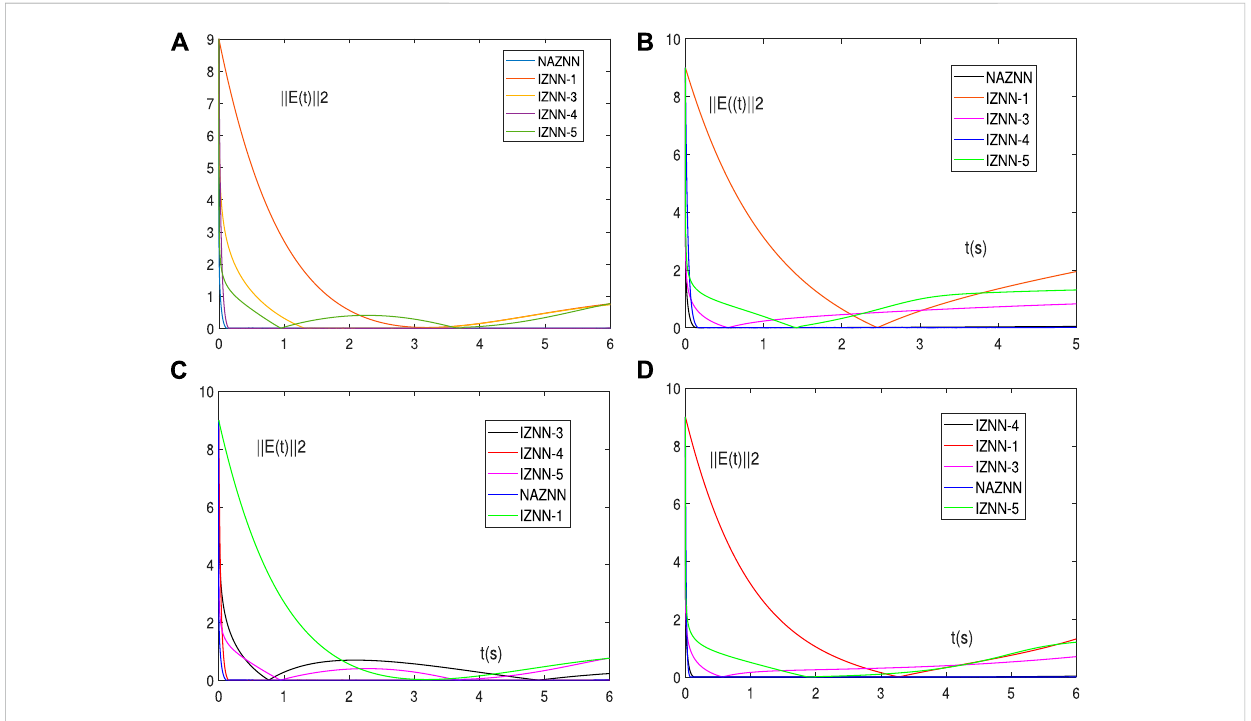
FIGURE 4 Residual errorsoftheNAZNNmodelandtheIZNNmodelsforsolvingEq.1whendisturbedbyvariousnoises. Thenoisesconsideredin (A-D) arethe same ones with (A-D)